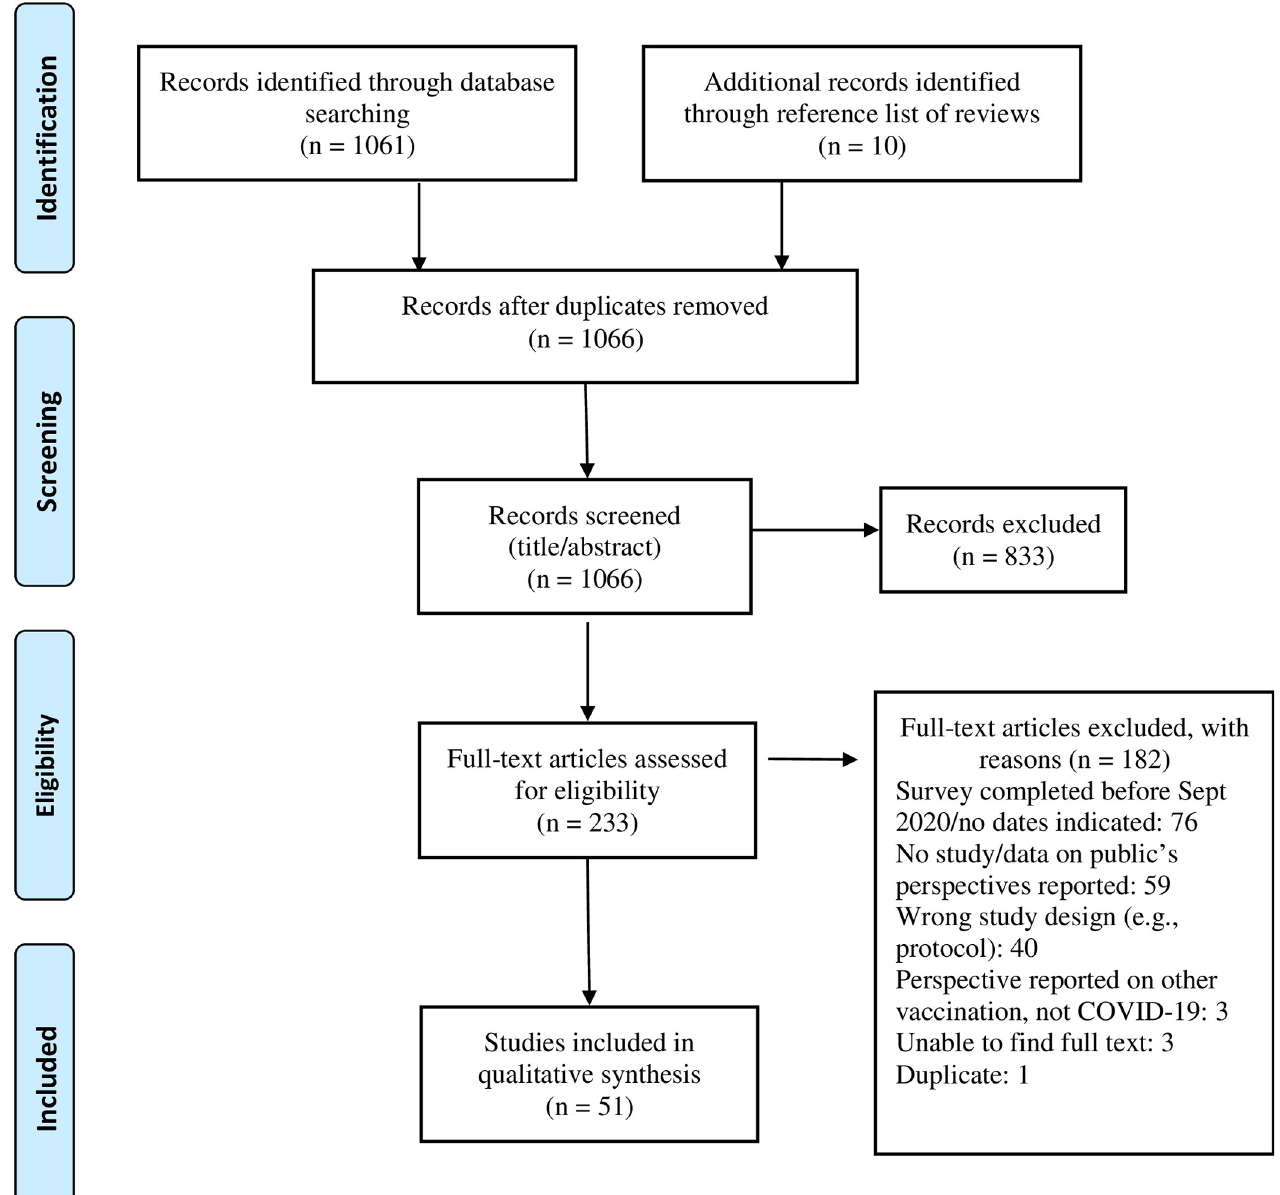
Fig 1. Preferred reporting items for systematic reviews and meta-analyses flow diagram of study selection